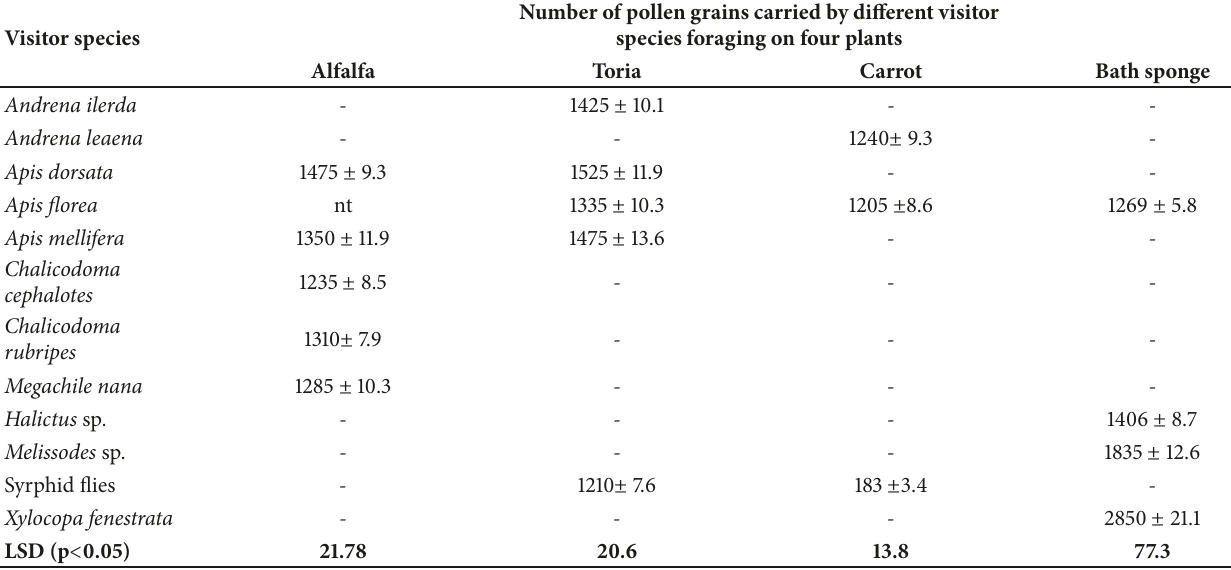
Table 1: Number of pollen grains carried by different visitor species foraging on four plants. Number of pollen grains carried by different Visitor species